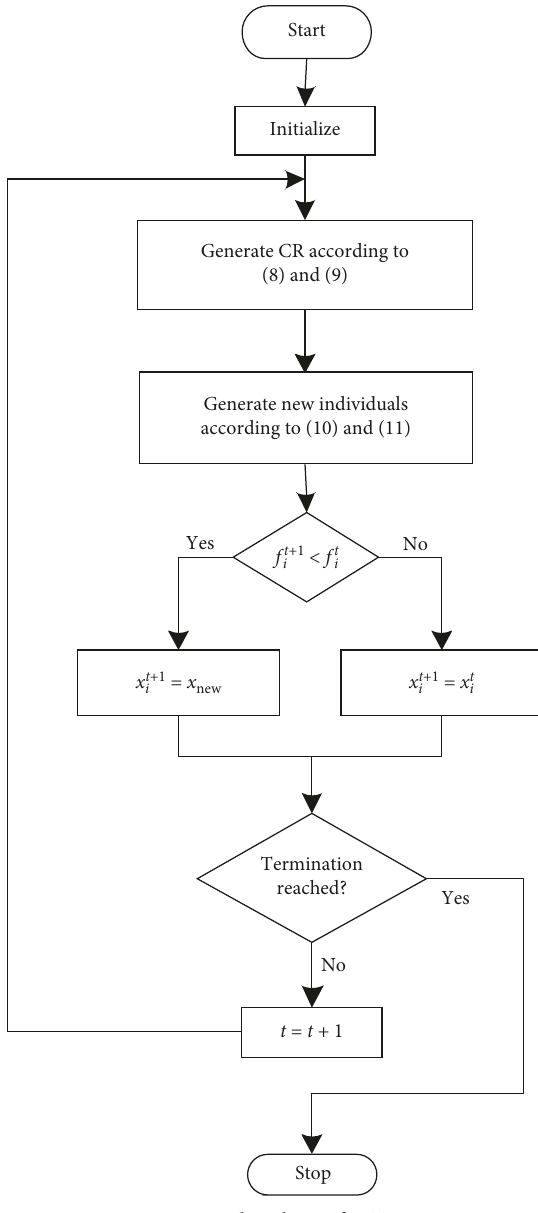
Figure 4: Flowchart of FITDE. Table 1: Ten benchmark